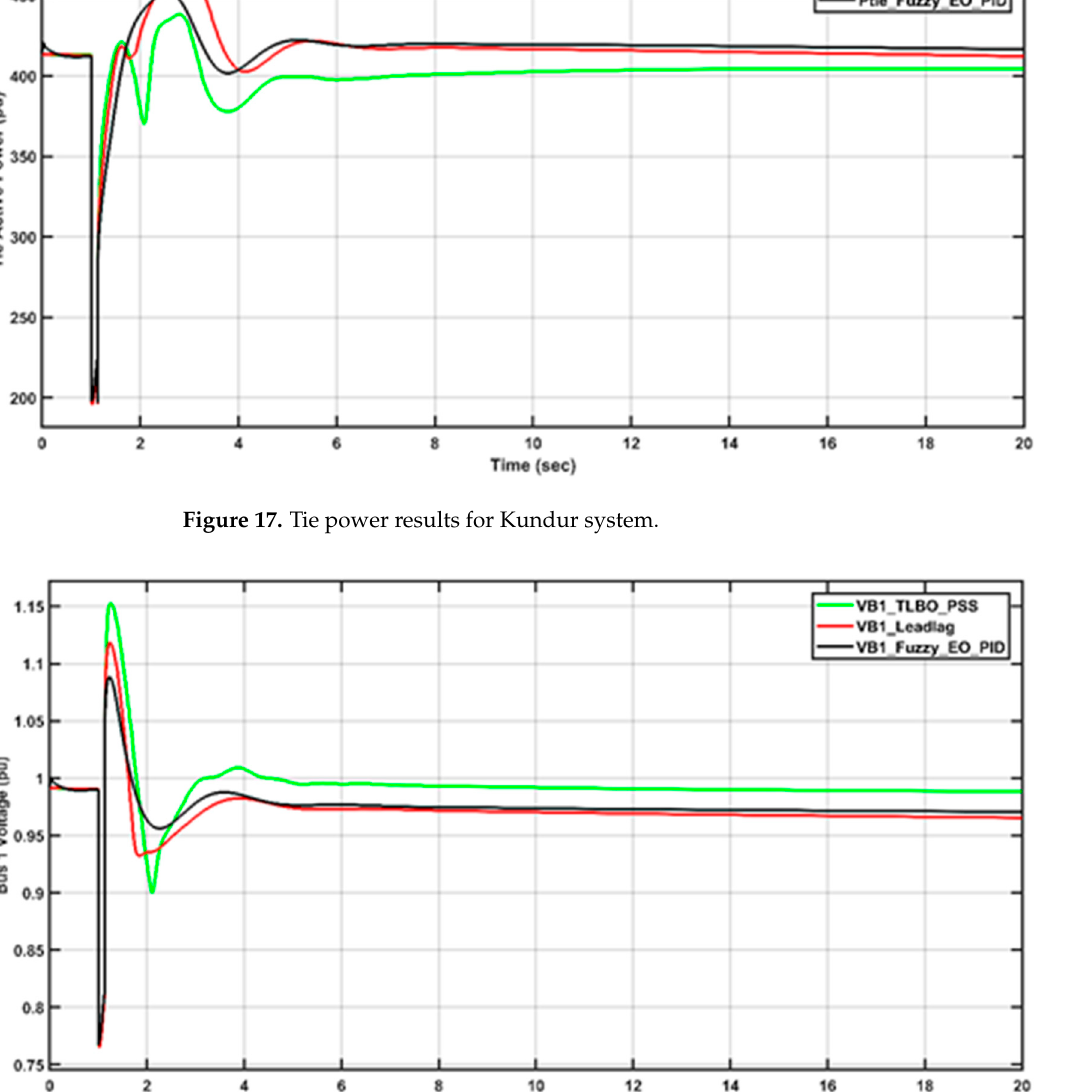
Figure 18. Bus 1 voltage results for Kundur system.